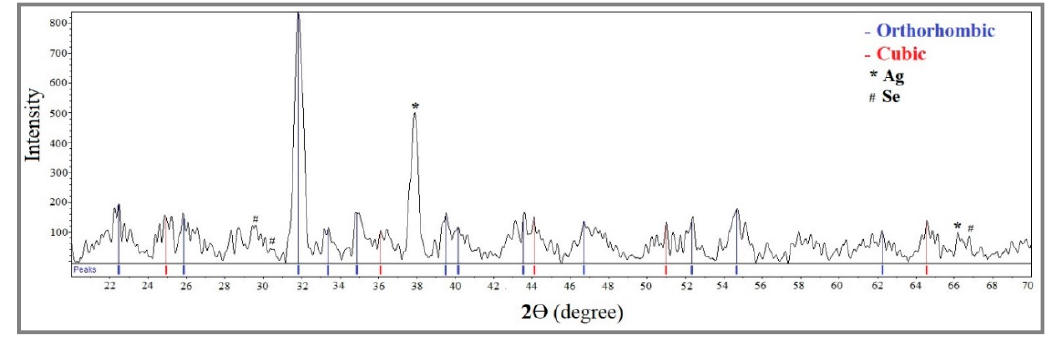
Figure 5. XRD diffractogram of Ag 2 Se NPs from sample E 3 . The red and blue vertical lines correspond to the cubic and orthorhombic phases of Ag 2 Se, respectively.